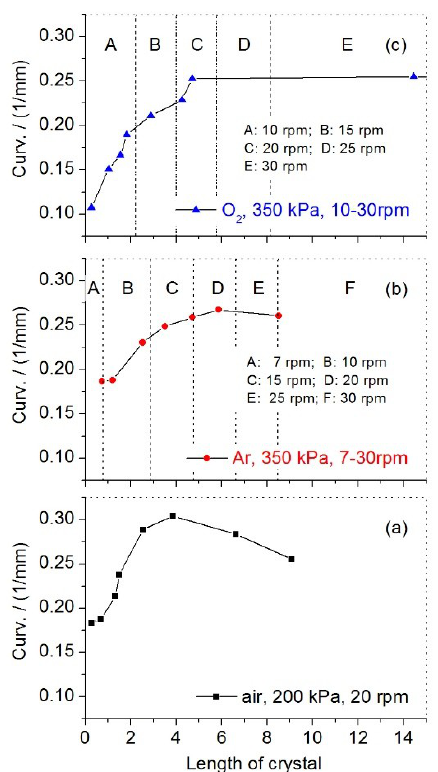
Figure 3. The evolution of the curvature of the striations of as‐grown Y 2 Ti 2 O 7 crystals obtained at different conditions: ( a ) for sample #2, ( b ) for sample #3, and ( c ) for sample #4.